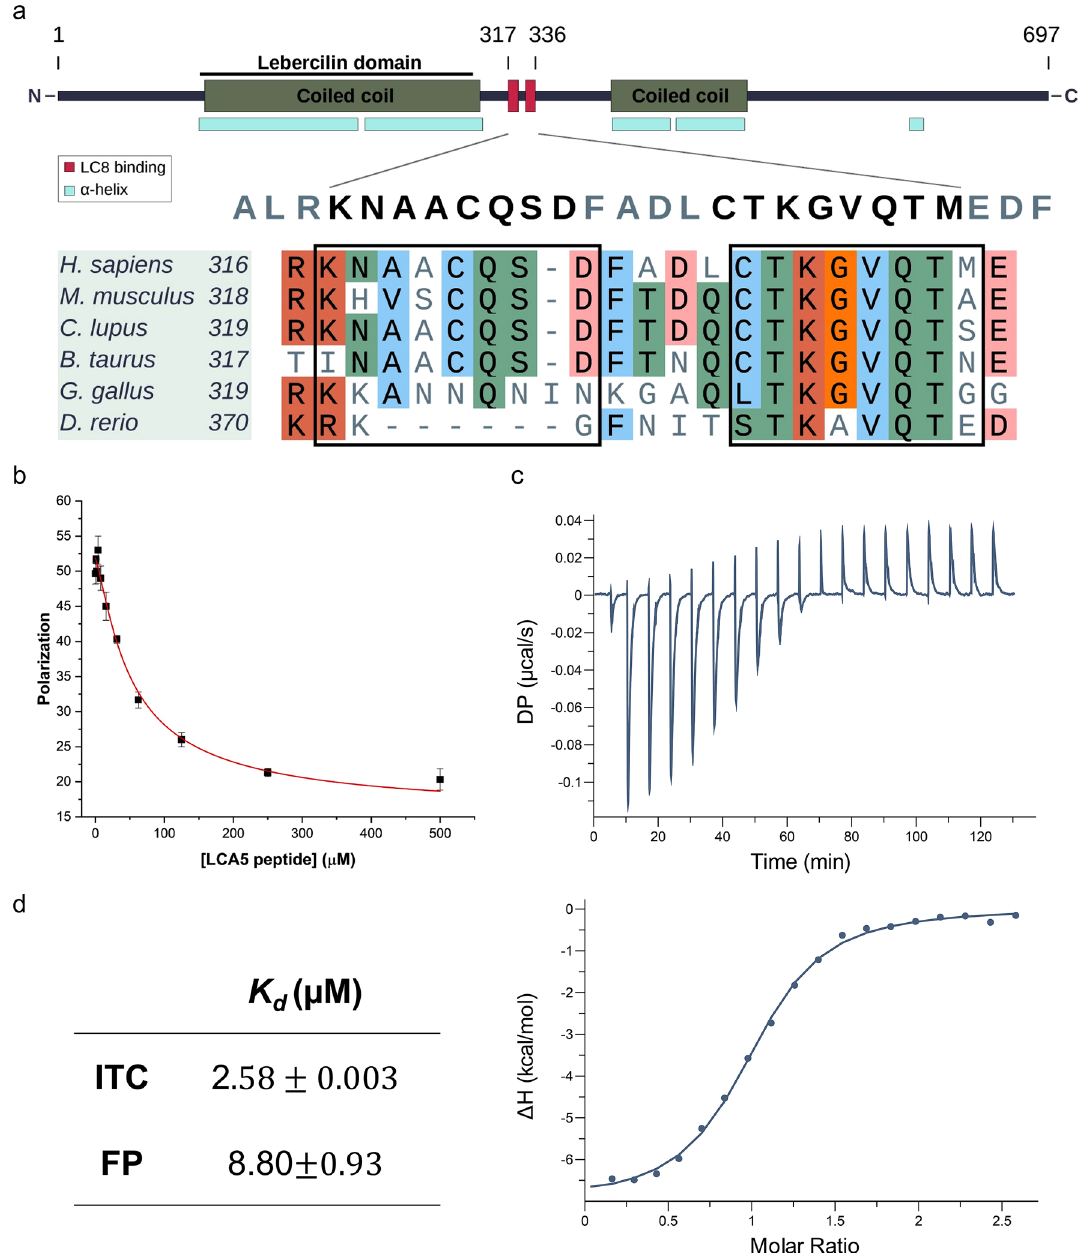
Figure 2. Sequence localization of the binding motifs in LCA5 and the interaction of the VQT motif with LC8. ( a ) The domain structure of the full-length LCA5 and multiple sequence alignment of the two putative LC8 binding motifs generated from the corresponding LCA5 orthologs. The high confidence score VQT motif is conserved through vertebrates, the lower score CQS core triplet-containing motif only emerged among mammals. ( b ) In competitive fluorescence polarization measurement, LCA5 binding motif-containing synthetic peptide (DLCTKGVQTME) was added to the complex of LC8 with fluorescein labeled BMF peptide. ( c ) ITC thermogram of LCA5 peptide injected to LC8 protein. ( d ) Comparison of the resulting K d -s of the LCA5 peptide—LC8 interaction from the two